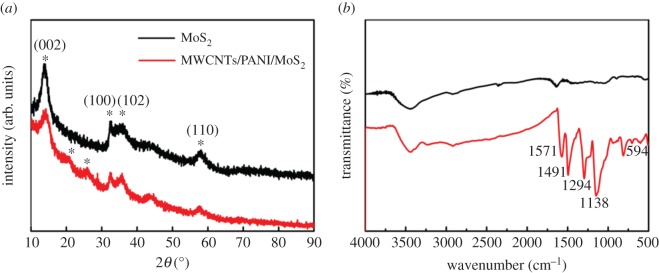
(a) XRD patterns and (b) FT-IR spectra of MoS2 and MWCNTs/PANI/MoS2 hybrid.